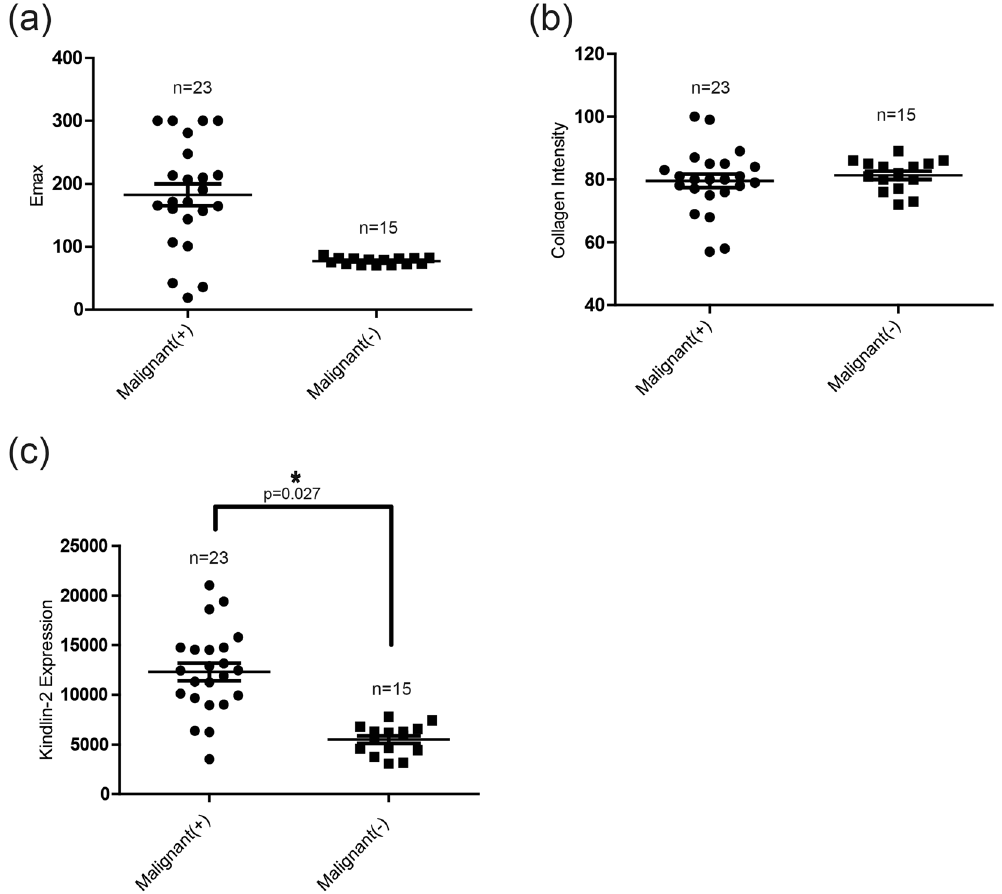
Figure 4. Expression levels of collagen and Kindlin-2 in malignant breast nodules with or without lymph nodes metastasis. ( a ) Emax of malignant breast nodules with lymph node metastasis were higher than that of nodules without lymph node metastasis, but it had no statistical significance (p = 0.110). ( b ) There was no difference in collagen intensity between the metastasis group and the non-metastasis group (79.54 ± 10.22 vs. 81.35 ± 5.10, p = 0.529). ( c ) Kindlin-2 expression of malignant breast nodules with lymph node metastasis was significantly higher than that of nodules without lymph node metastasis. Values are means ± SD. Comparisons between two groups were made using Student’s t -test. * p < 0.05, ** p < 0.01. Emax, maximum elasticity; SD, Standard